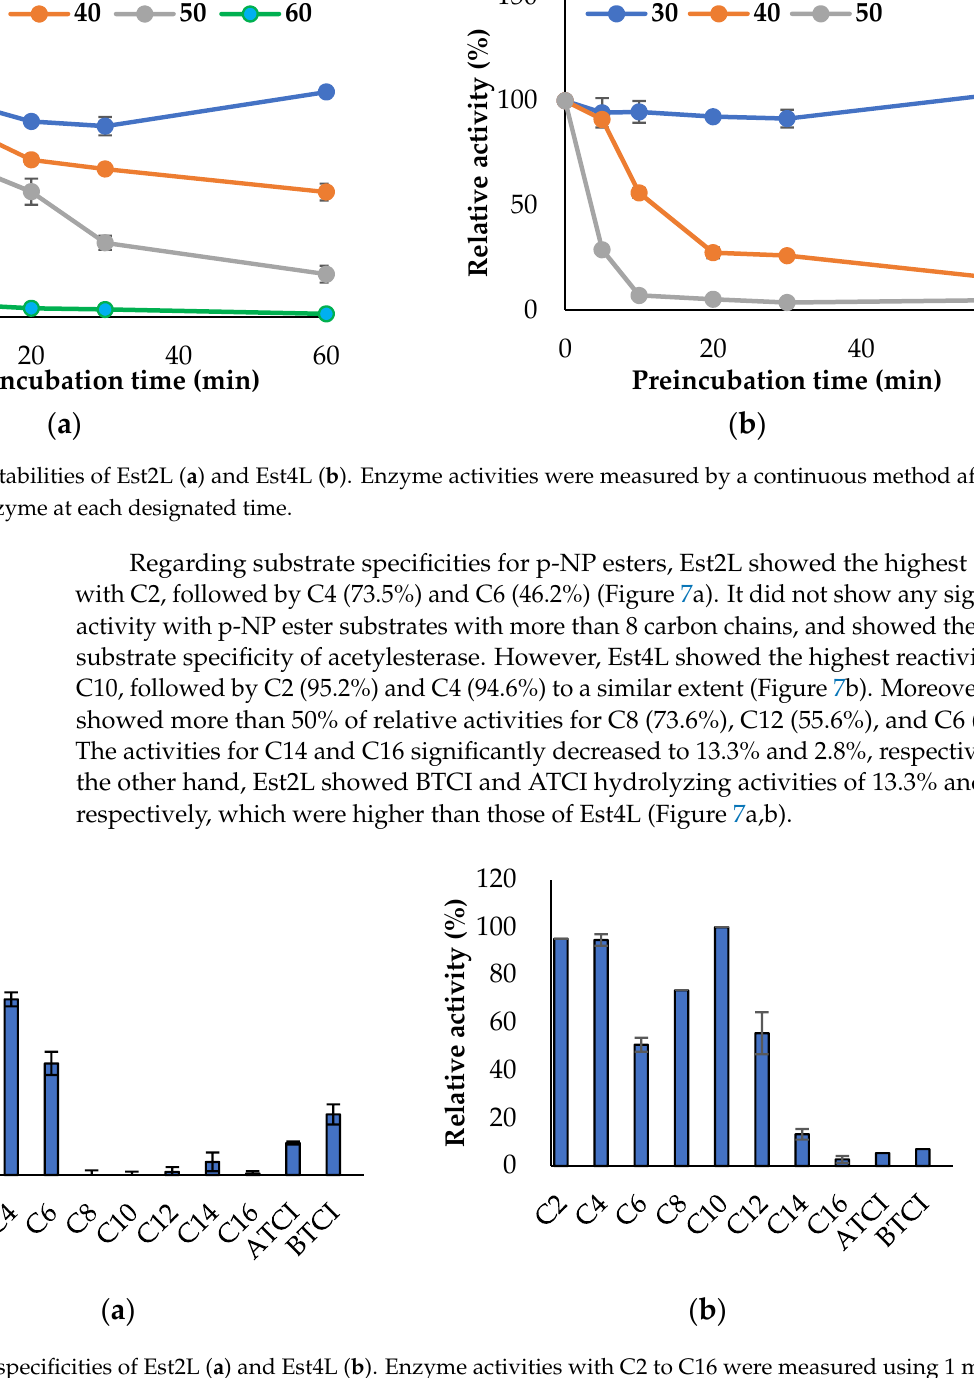
measured using 1 mM p -nitrophenyl esters in 50 mM Tris-HCl (pH 8.0), and those of p -nitrophenyl esters in 50 mM Tris-HCl (pH 8.0), and those of acetylcholinesterase (AChE) and butyrylcholinesterase (BChE)